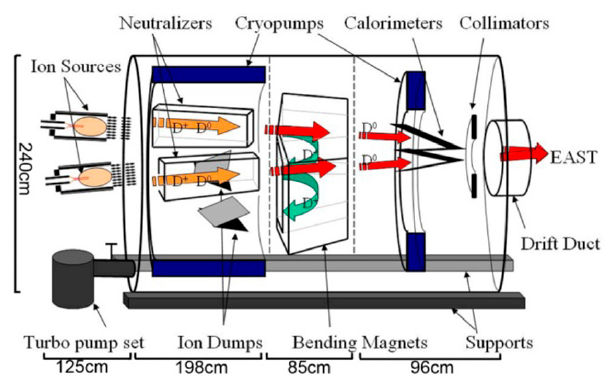
Figure 1. Three-dimensional schematic diagram of the existing EAST-NBI vacuum chamber and components.